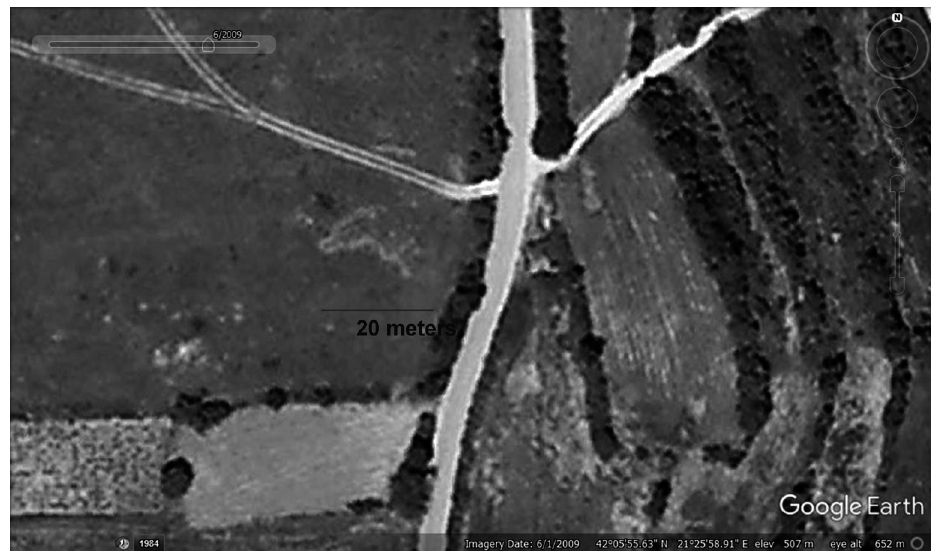
Figure 6: The remains of a villa building in the survey area, north of